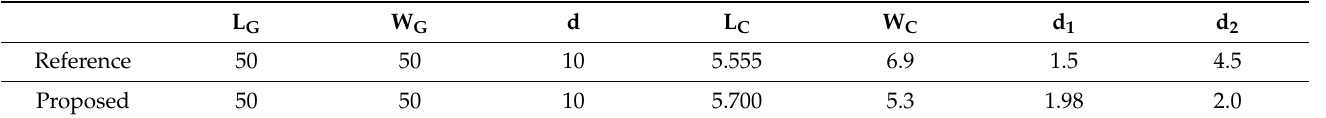
Table 1. Dimensions of fabricated antennas. (Unit: mm).